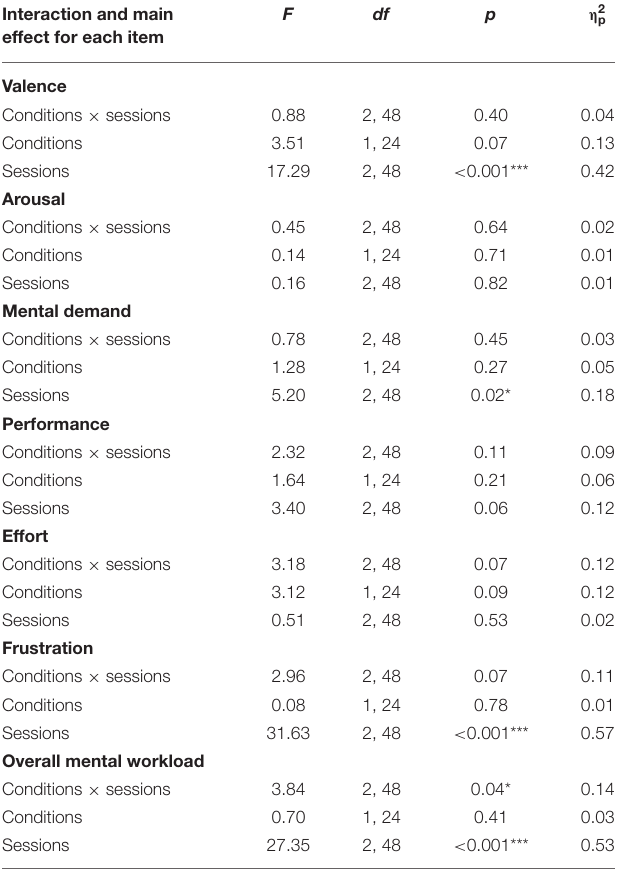
TABLE 3 | Results of ANOVA for subjective ratings. Interaction and main effect for each item